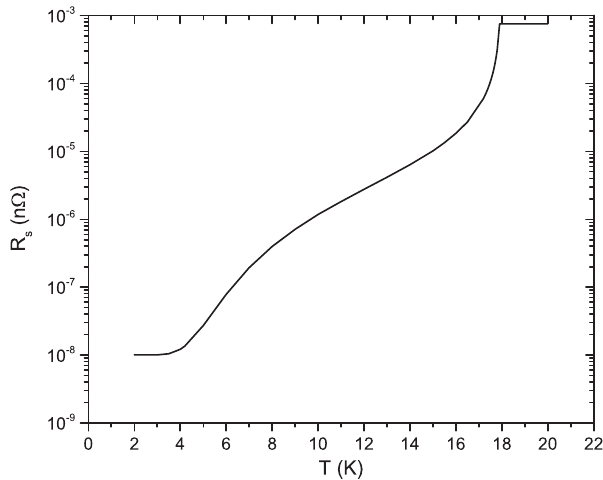
FIG. 12. Temperature-dependent surface resistance of Nb 3 Sn used in the thermal analysis.